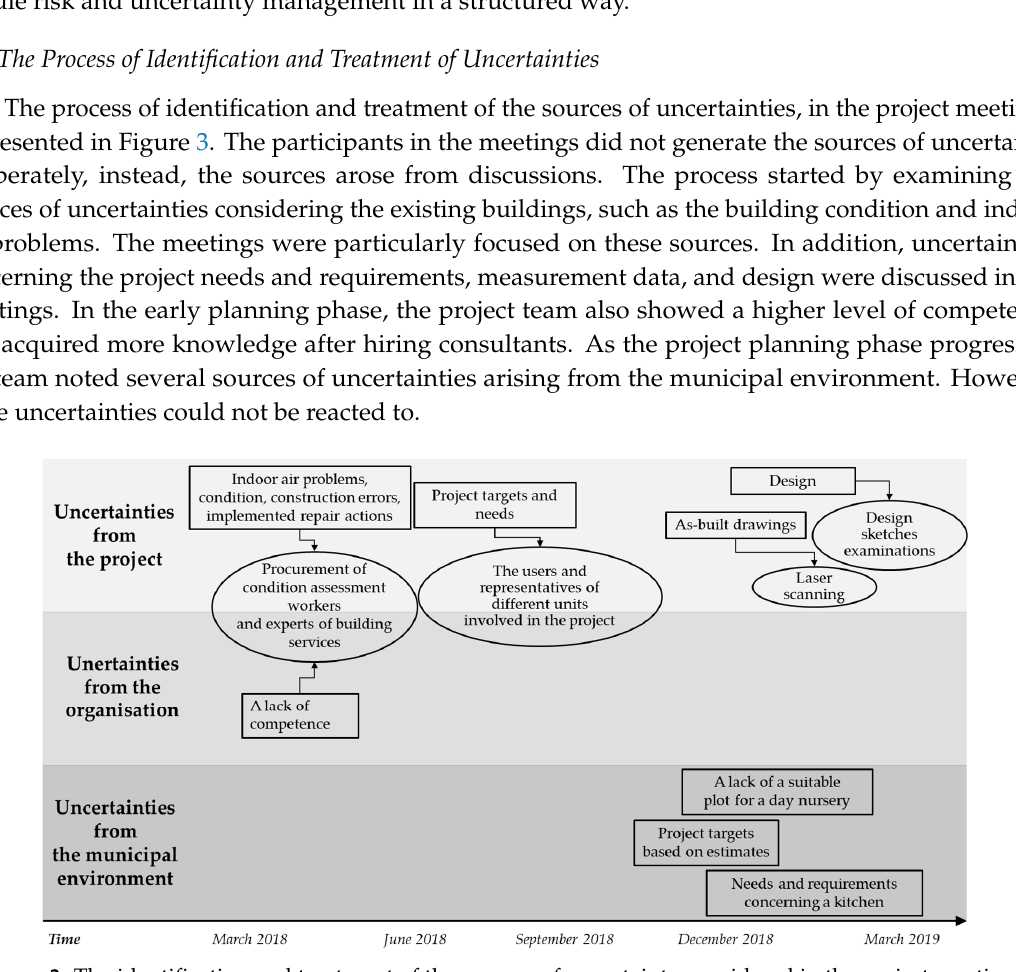
Figure 3. The identification and treatment of the sources of uncertainty considered in the project